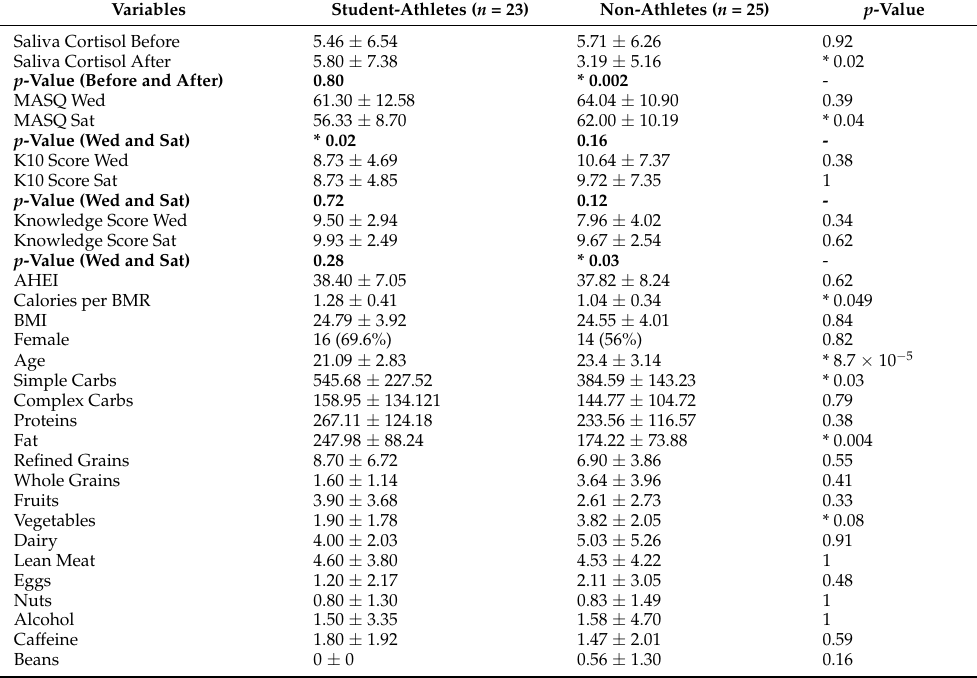
Table 1. Summary of characteristics of student-athletes and non-athletes. * p < 0.1.